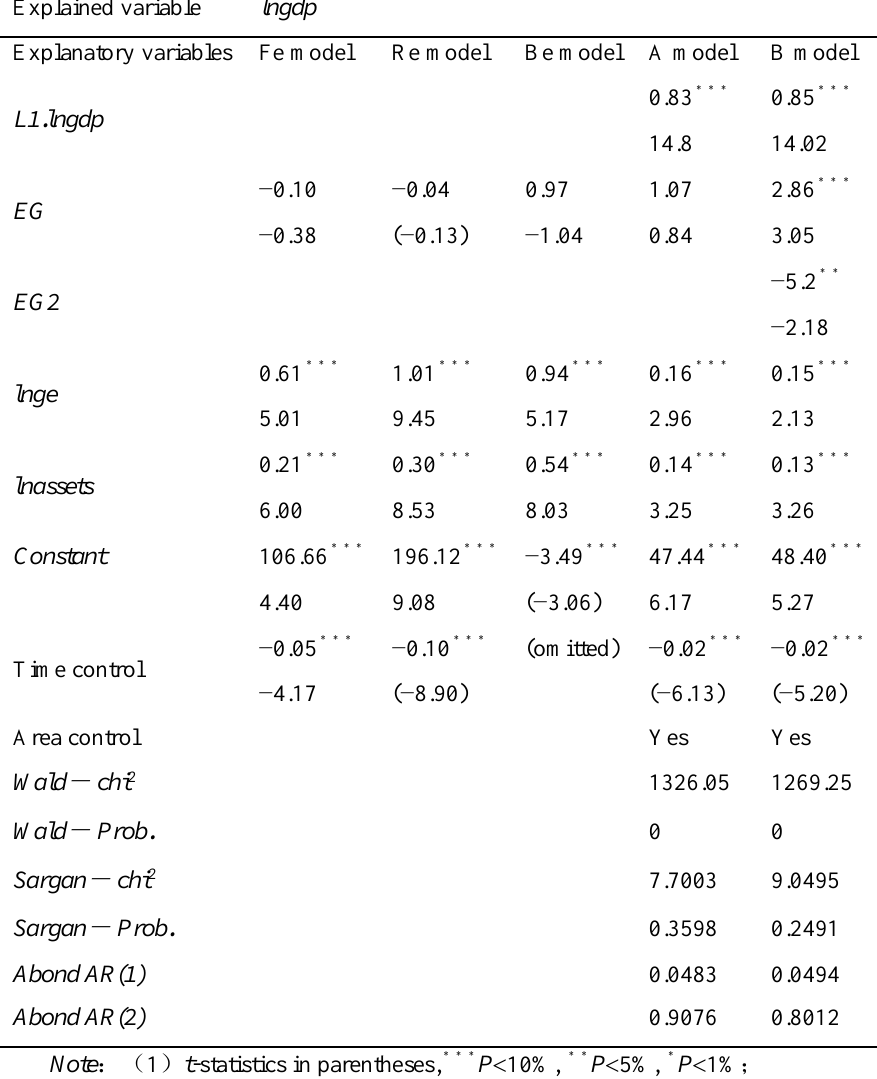
Table 3 Estimated results of EG indices and economic